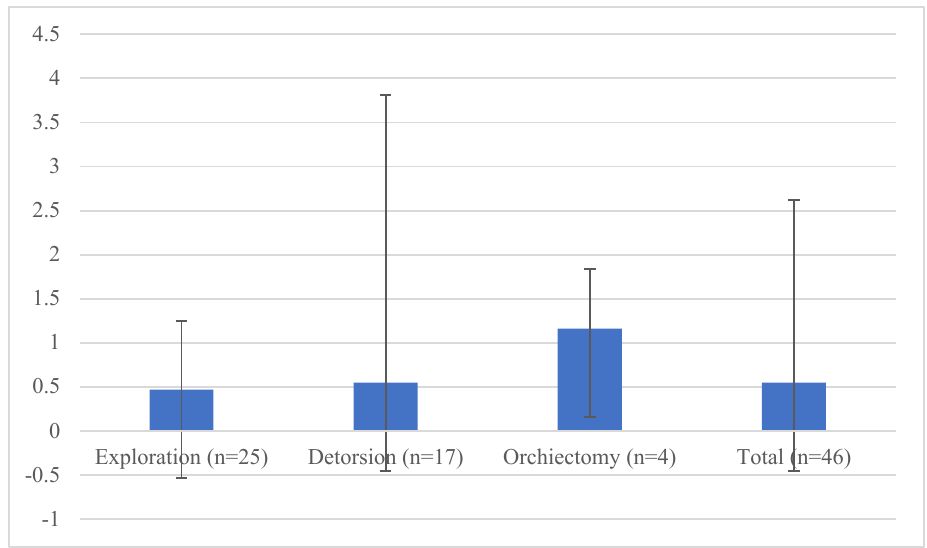
Figure 2. Analysis of oxidative stress (OS) in relation to the surgery performed.